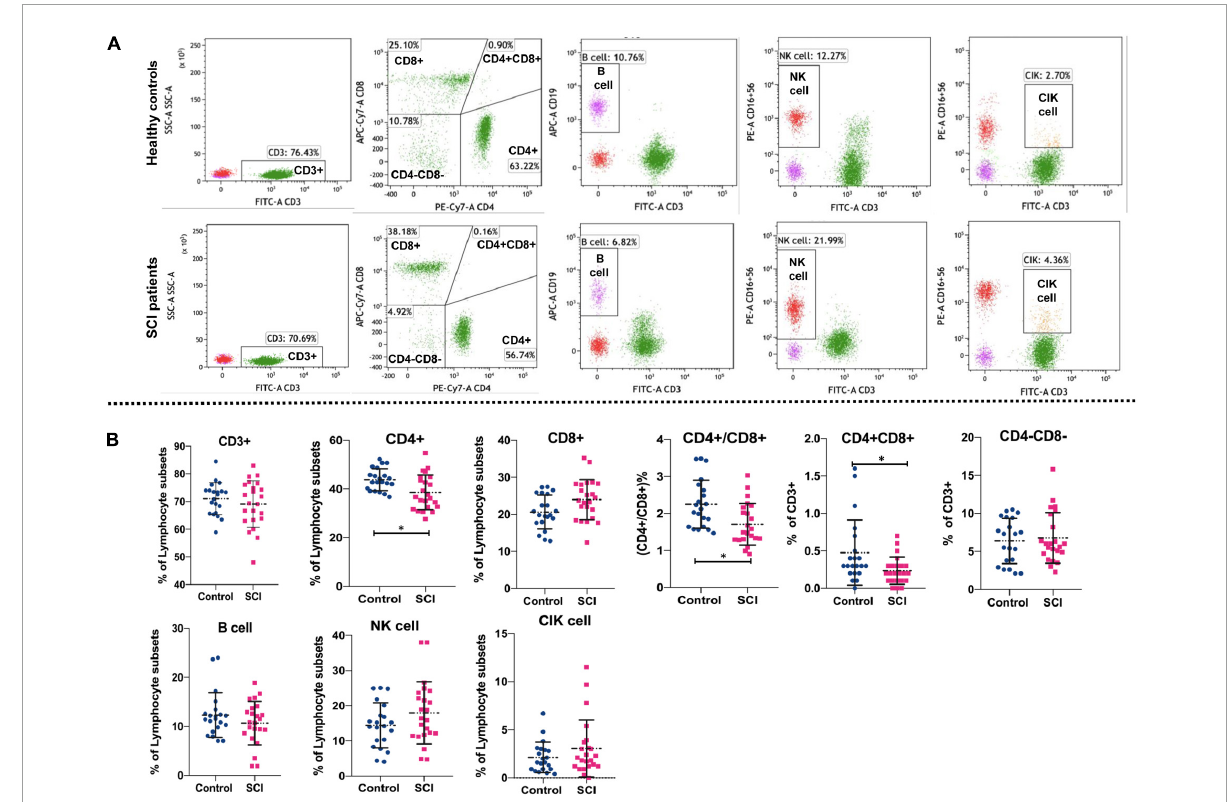
FIGURE1 Comparison of lymphocyte subsets in SCI group and control group. Flow cytometry analyzed major T lymphocyte subsets, NK cells, B cells and CIK cells. Representative (A) and quantitative results (B) were shown. The cells analyzed included CD3 + cells, CD4 + cells, CD8 + cells, CD4+/CD8+, CD4 + CD8+, CD4-CD8- cells, B cells, NK cells, and CIK cells. ∗ P <